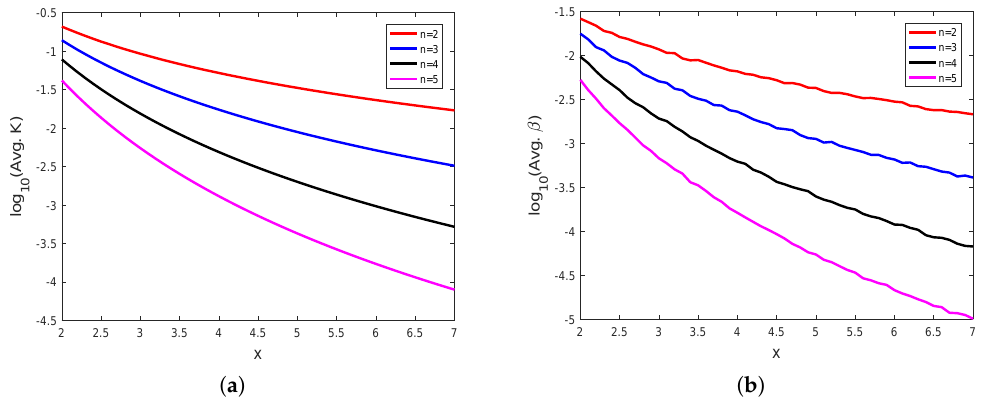
Figure 10. ( a ) Logarithm of Bates and Watts parameter-effects curvature (log logarithm of direct parameter-effect curvature (log